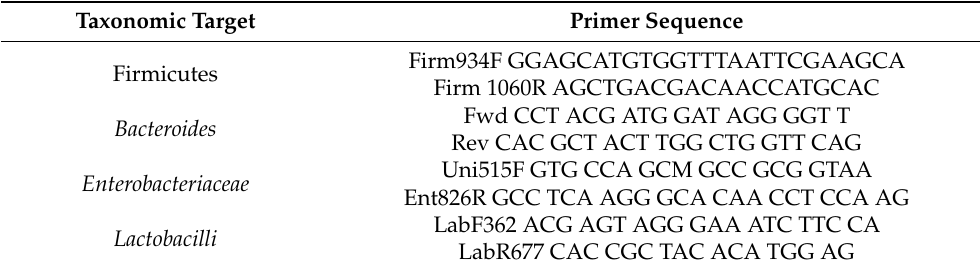
Table 2. Primer sequences used for microbiota characterization. Taxonomic